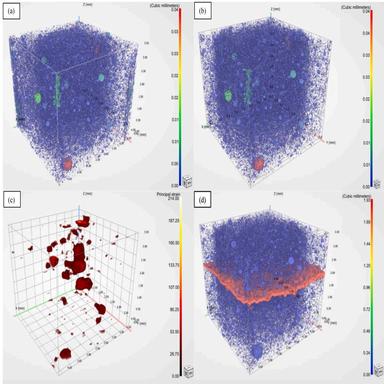
3D rendering of segmented phase in strain-hardening cementitious composites (SHCC) sample under an in-situ uniaxial tensile microtomographic test: (a) connected pore network in the order of increasing volume at the initial state, (b) connected pore network in the order of increasing volume before cracking, (c) major principal strain εeq field before cracking, (d) connected objects for pore phase in the order of increasing volume after cracking. Colour bars in (a), (b), and (d) represent the volume of segme